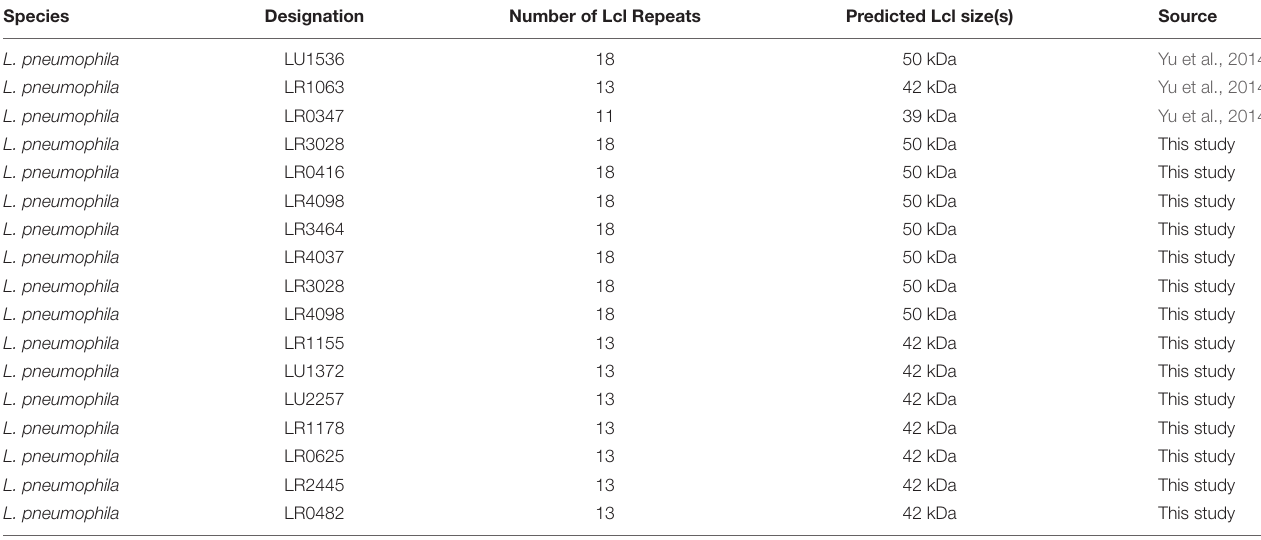
TABLE 2 | Legionella pneumophila clinical strains used in this study. Species